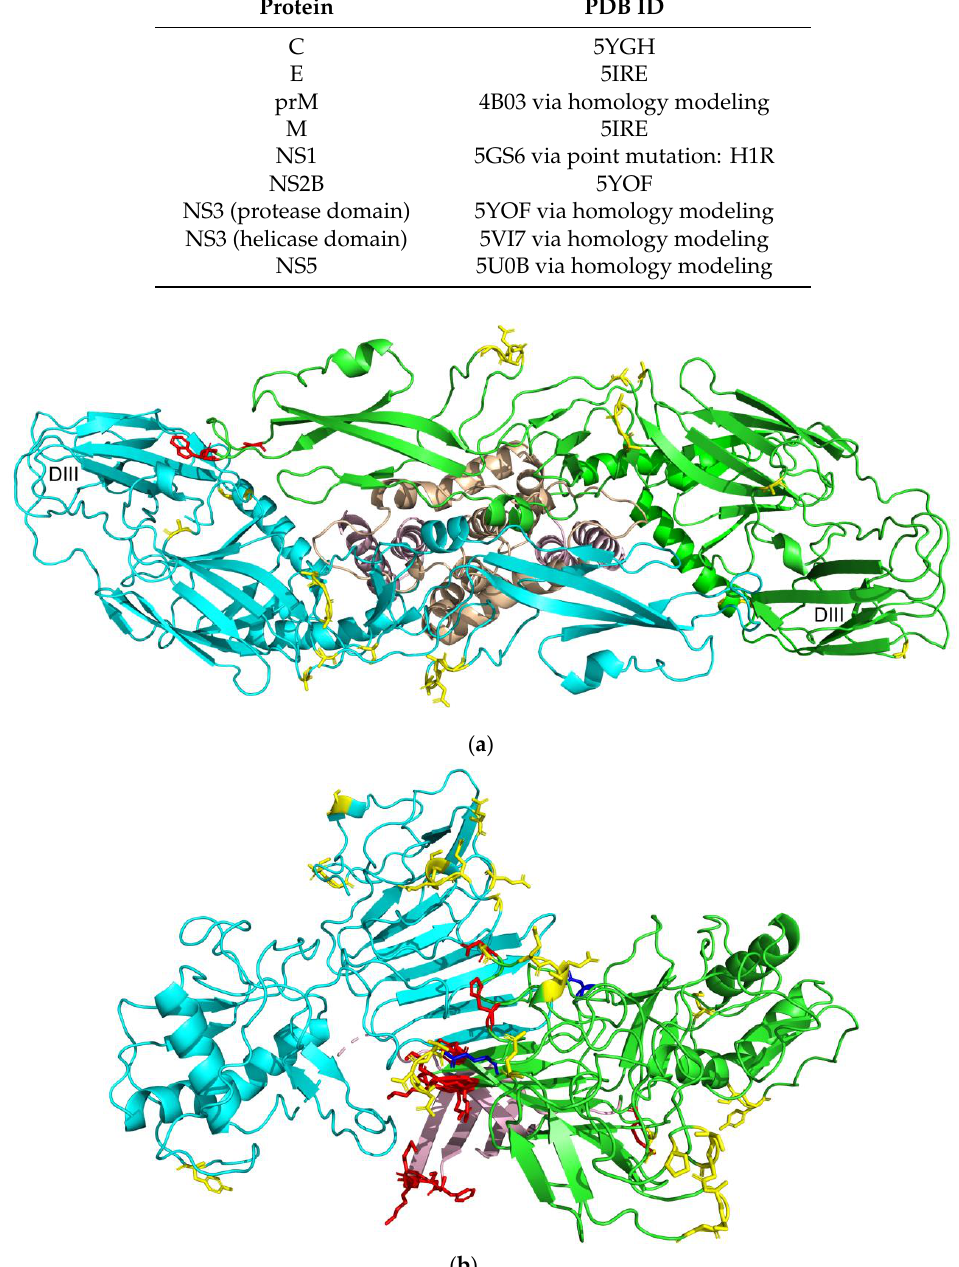
Figure 8. Conformational epitopes mapped to their respective proteins. Epitope residues are colored yellow. Epitopes only found in the monomeric structure are colored red, and epitopes only found in the multimeric structure are colored blue. ( a ) E protein (from above) in the form of E-M heterodimer. The chain used to find monomeric epitopes are colored green, transmembrane domains are colored pink and M proteins are colored tan; ( b ) NS1 protein as a dimer. The chain used to find monomeric epitopes are colored green, the beta-roll domain is colored pink.